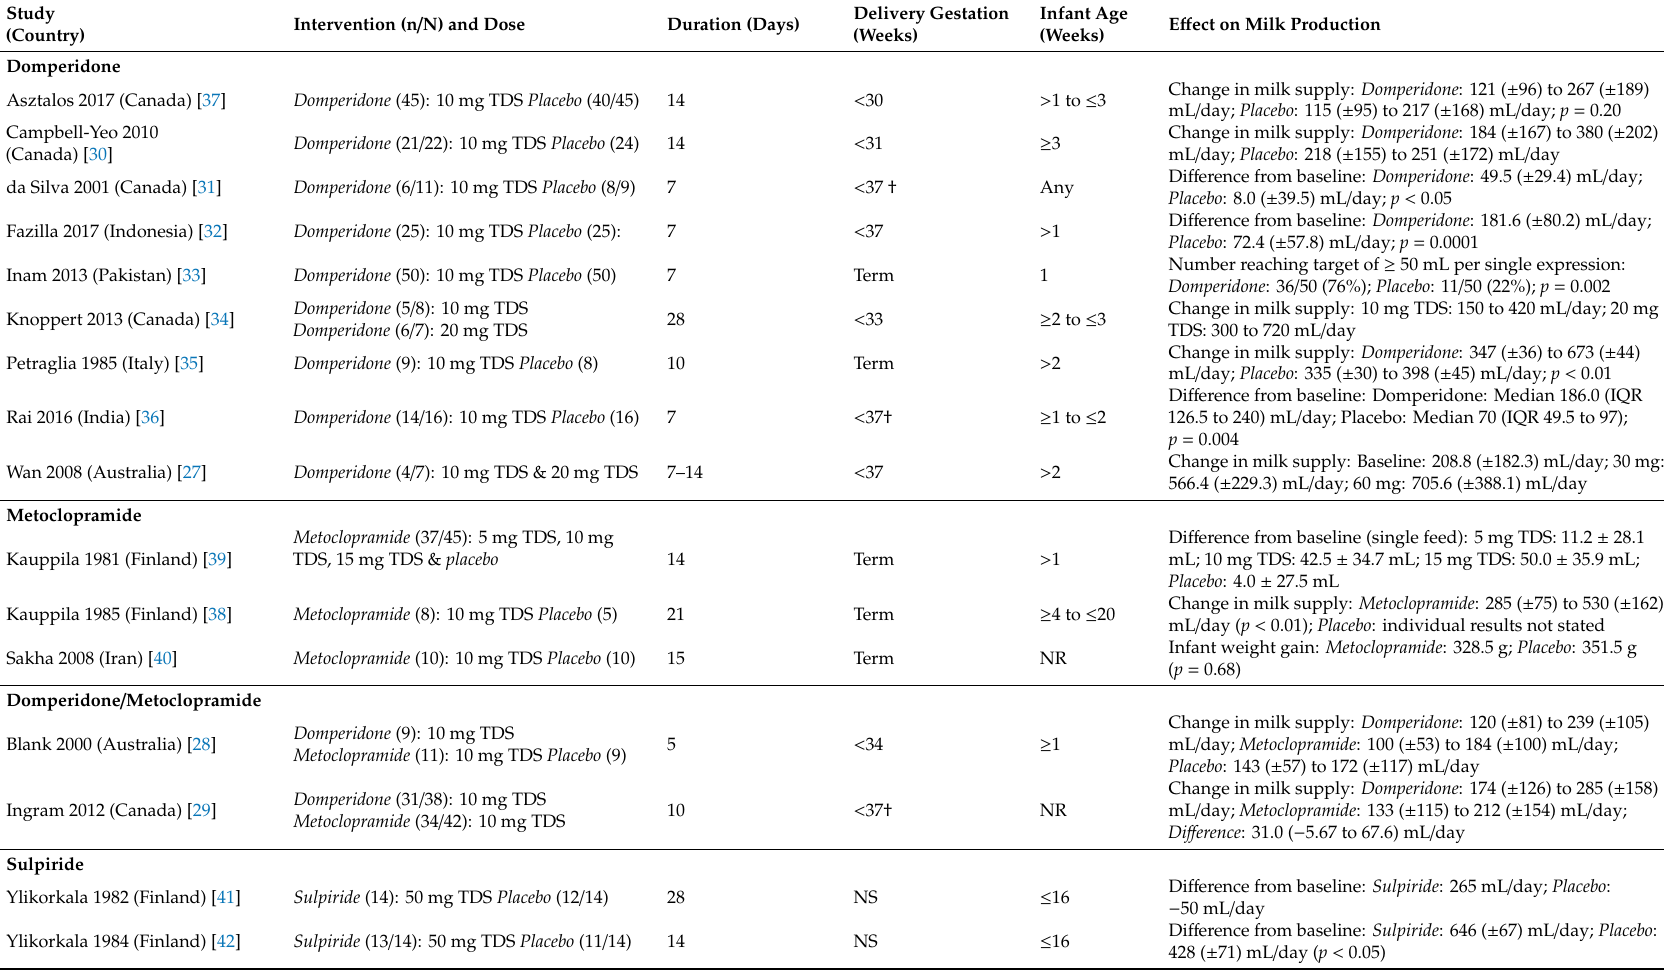
Table 1. Overview of controlled studies evaluating the e ffi cacy of pharmaceutical galactagogues for the treatment of lactation insu ffi